Question: In one sentence, what is this figure communicating?
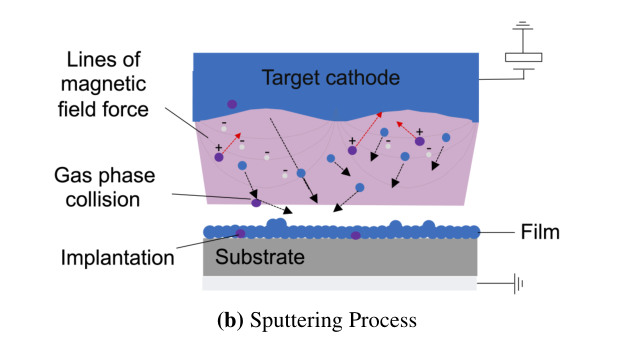
Answer: Vacuum chamber geometry, as shown in Fig. 3a, is used for physical vapor deposition employing a top-down sputter geometry with true planetary sample stage motion (i.e., orbit + spin). Ultra-high-purity argon gas is consistently introduced into the chamber and regulated by a mass flow controller (MFC). Fig. 3b shows the cross-section drawing of key atomistic processes involved in sputtering, transport, and film growth.